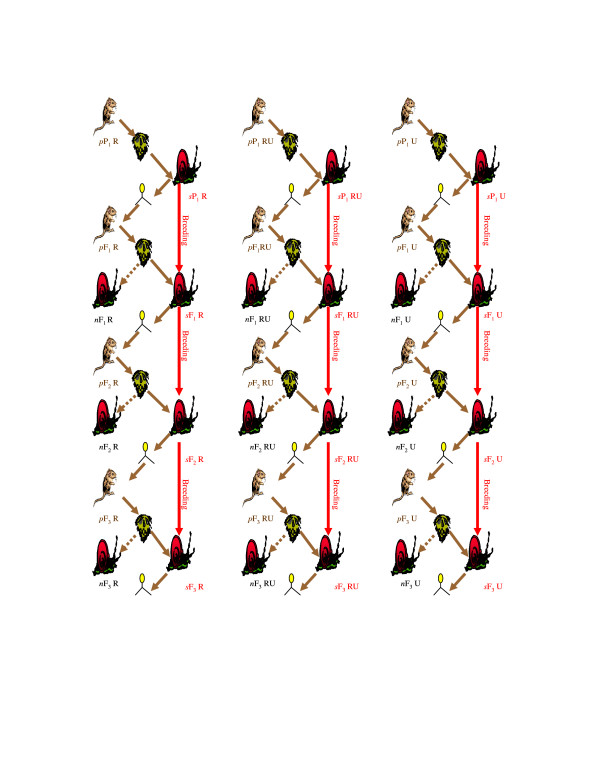
Host-parasite co-selection (and cross-infection) design. Solid lines represent host and parasite co-selection over generations. Only one replicate illustrated, for simplicity, from: three lines of S. mansoni co-selection passage through either R (artificially-selected resistant snails); R:U (equal mix of resistant-selected and unselected snails) or U (unselected snails), of four replicates per co-selection line per P1-F3generation (s for snail; p for parasite line) mass exposed to a matched dose of S. mansoni, at n = 20 s snails per 'population' per line replicate per generation. Broken lines represent parasite (p) exposure to novel (n) non-coselected snail (cross-infections) at n = 10 n snails per 'population' per line replicate per generation). Given the generation times of the parasite for harvesting in each of its obligatory host stages (7 weeks in the snail; 8 weeks in the mouse), each line/replicate here represents a minimum of 62 weeks (approx 1.2 years) continuous co-selection data collection (in addition to the preceding approx 2.4 years continuous snail host only P1-F6 artificial selection for resistance).